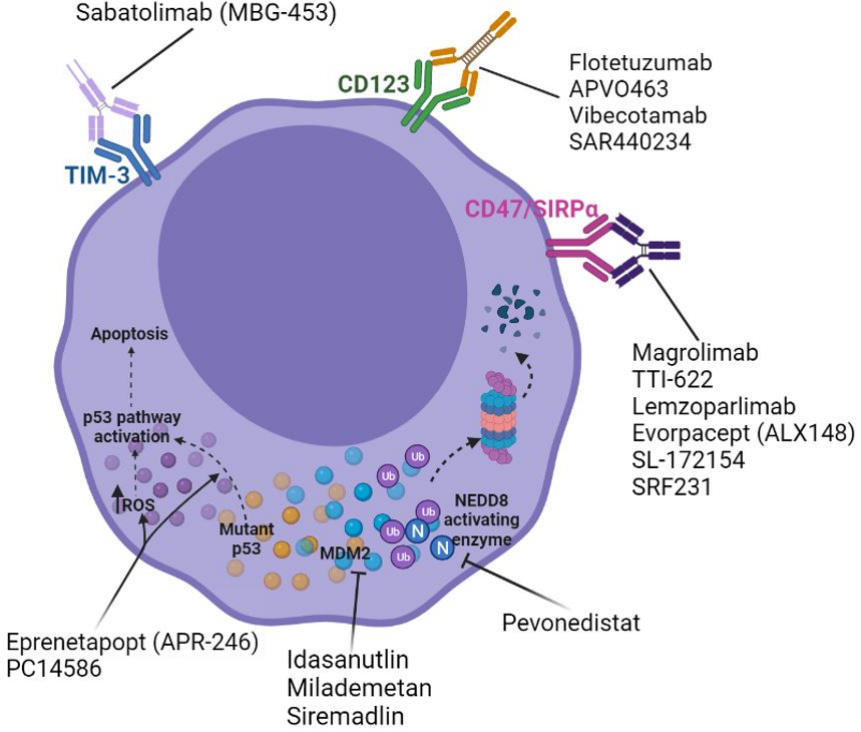
Figure 1. Emerging frontline agents for the treatment of TP53 -mutated acute myeloid leukemia.